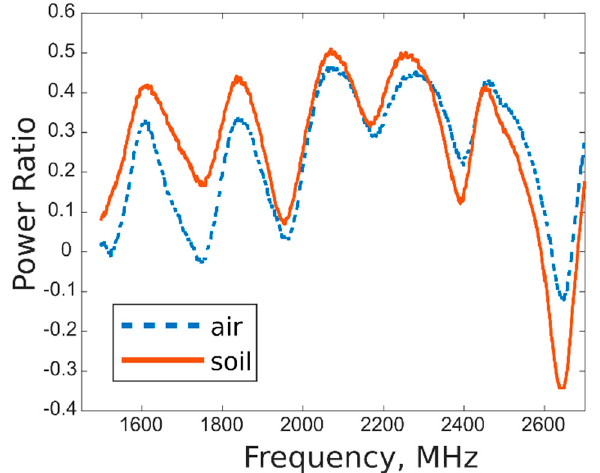
Figure 9. Characterization of mutual coupling between Tx and Rx antennas, for acquisitions on air and soil.